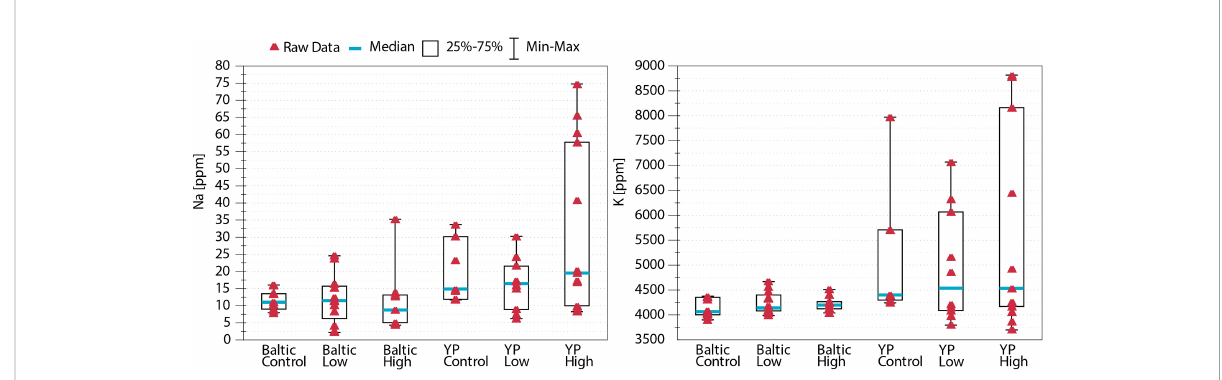
FIGURE 2 Concentrations of Na and K in the studied pollen — variance and descriptive statistics. The addition of NaCl to the soil increased the variation in both Na and K in pollen. N =